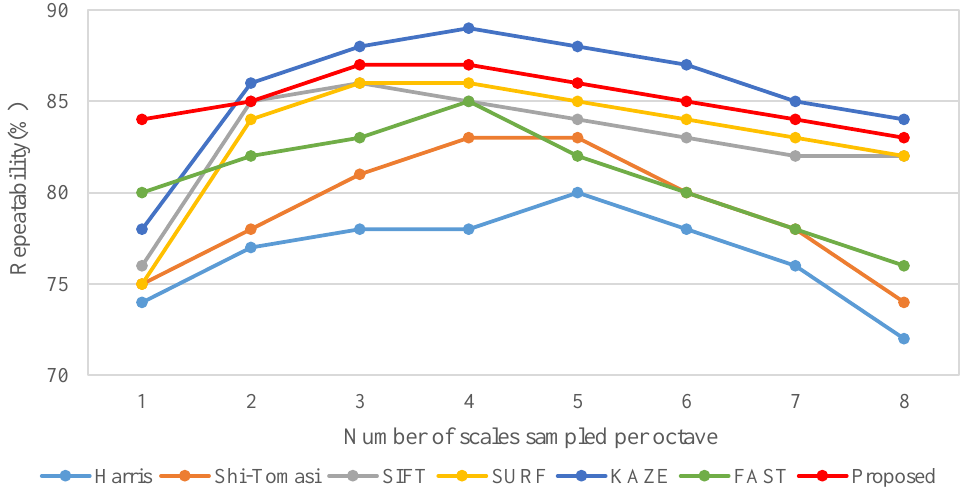
Figure 4. Performance comparison between MAGAST (proposed) and other feature detectors with relationship between the number of scales and repeatability.